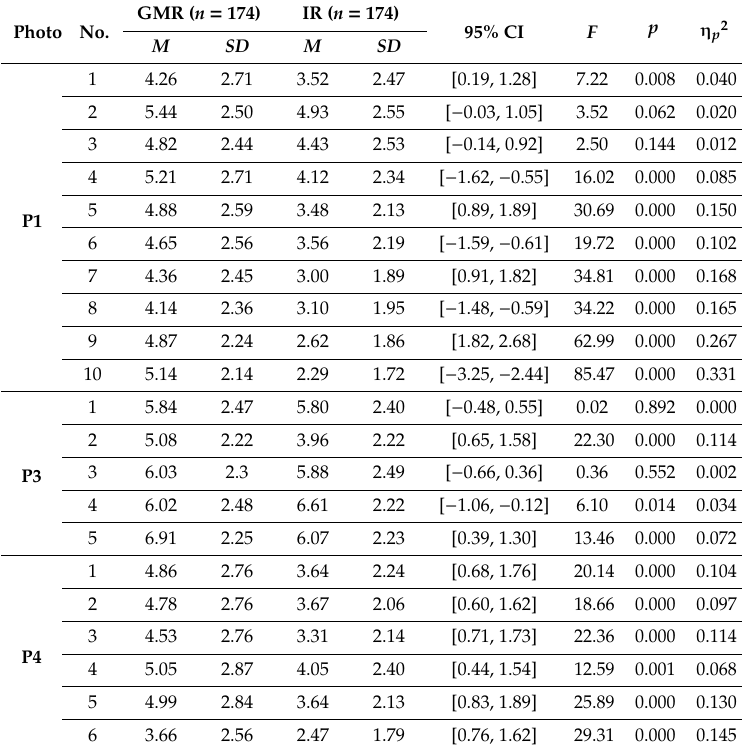
Table 4. Comparisons between GMR and IR from Study